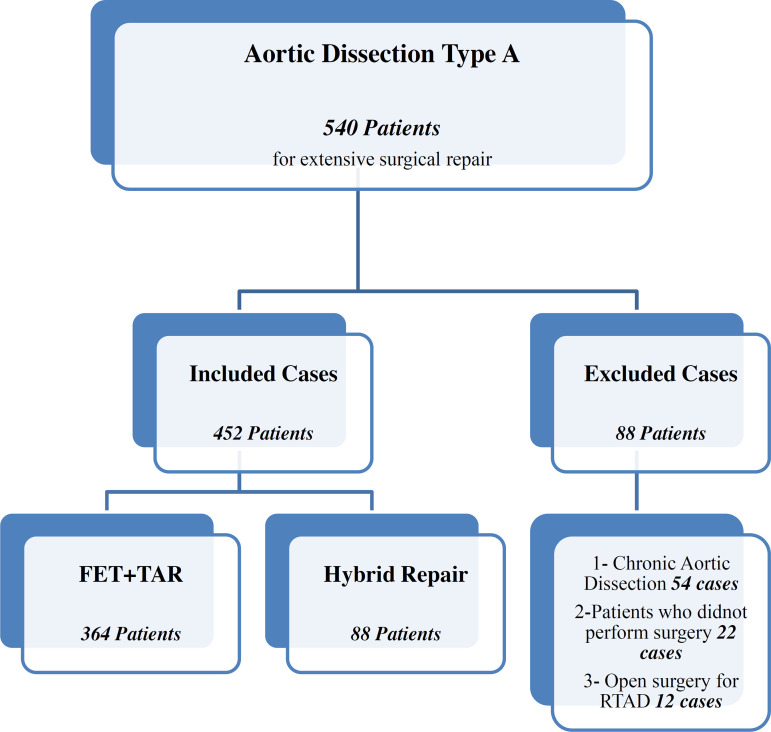
Flow chart picture showing included and excluded cases. FET=frozen elephant trunk; RTAD=retrograde type A aortic dissection; TAR=total aortic arch replacement